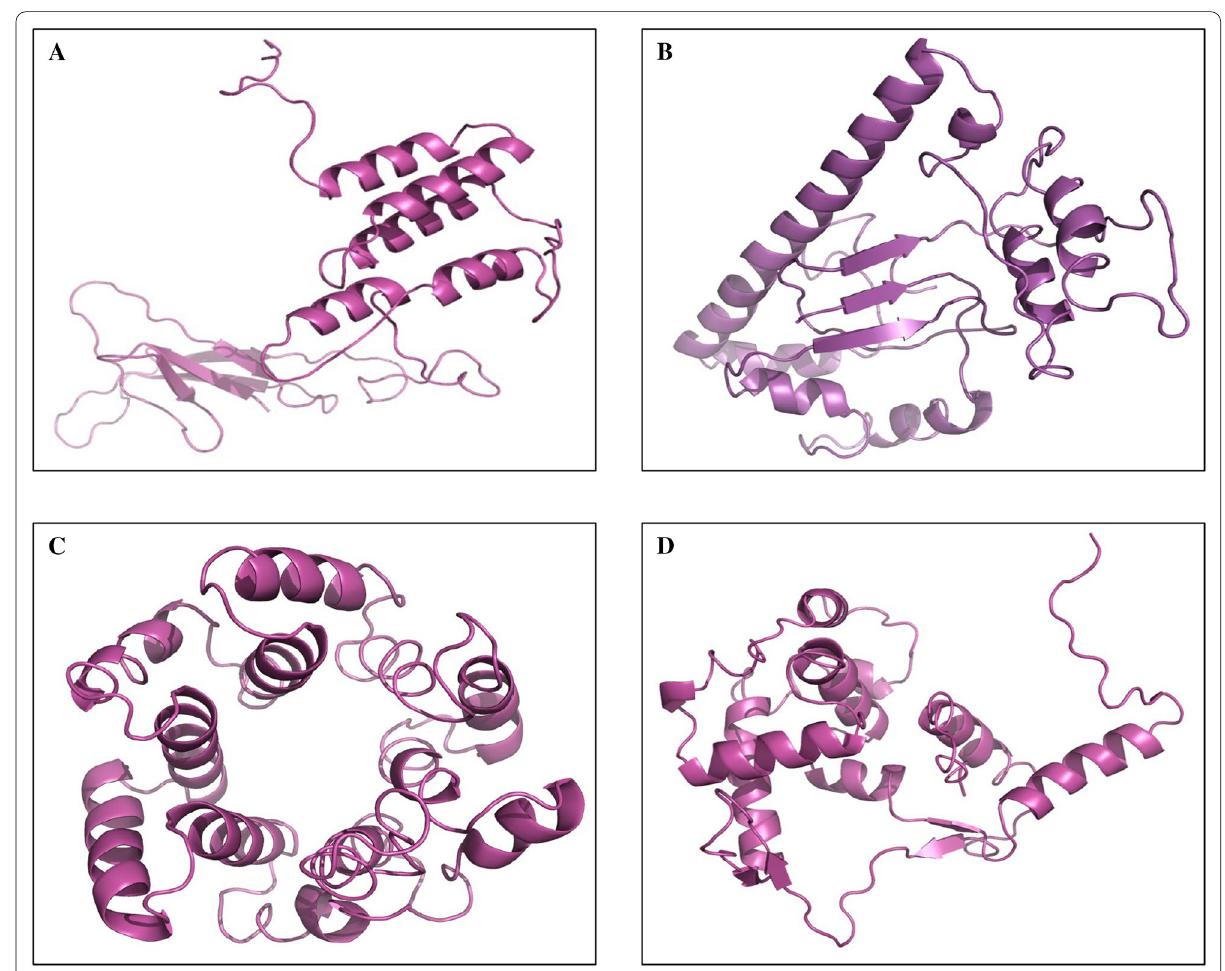
Fig. 6 The 3D structures of the Y-domain of HEV modelled using different online servers: ( A ) RaptorX; ( B ) Phyre2; ( C ) I-TASSER (model 1); and ( D ) I-TASSER (model